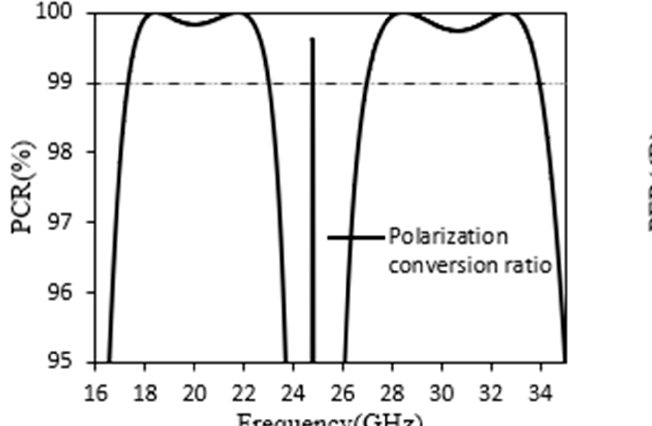
Figure 3. The calculated results of the proposed rectangular-slot converter under y -polarized inci- dence. ( a ) Axial ratio (dB) and ( b ) 𝑟 (cid:3019)(cid:3009)(cid:3004)(cid:3017)(cid:2879)(cid:3052) and 𝑟 (cid:3013)(cid:3009)(cid:3004)(cid:3017)(cid:2879)(cid:3052) (dB).